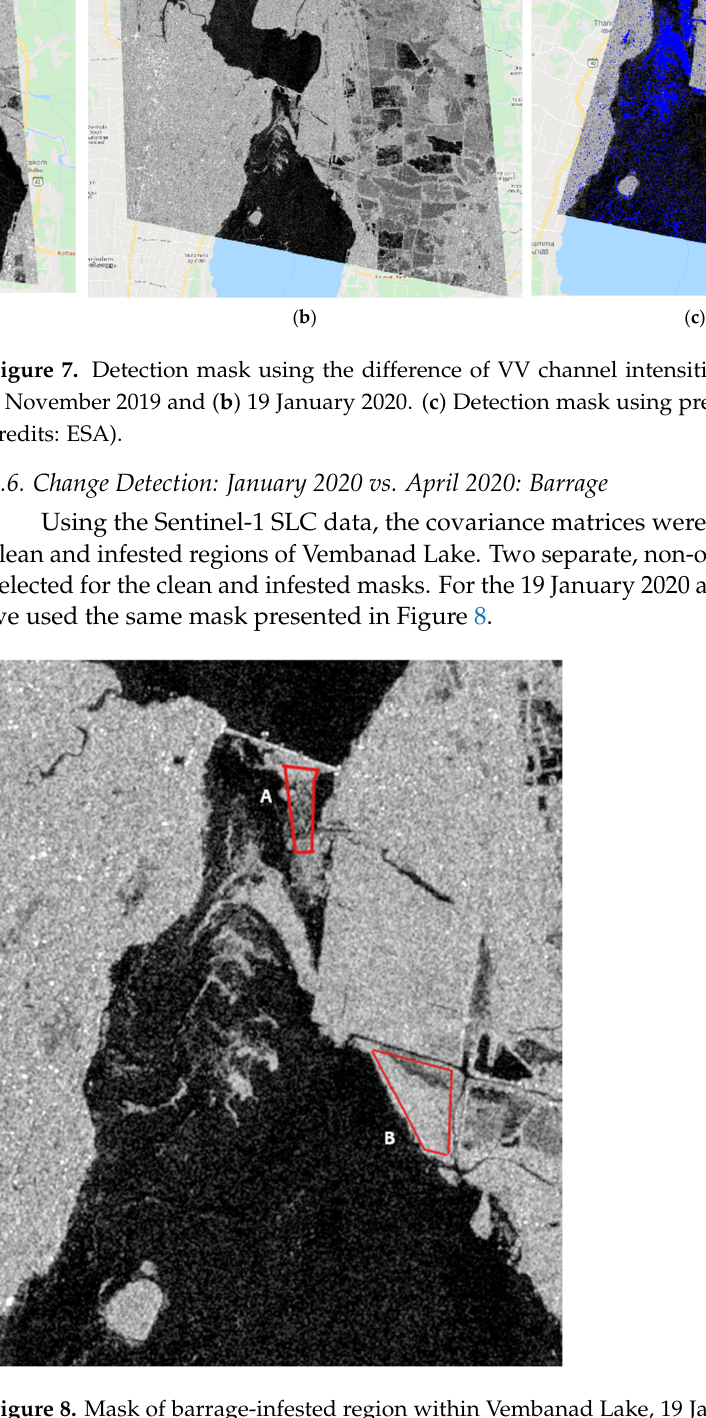
Figure 8. Mask of barrage-infested region within Vembanad Lake, 19 January 2020. ( A , B ) The red polygons highlight the region used for the infected masks. (Sentinel-1, Credits: